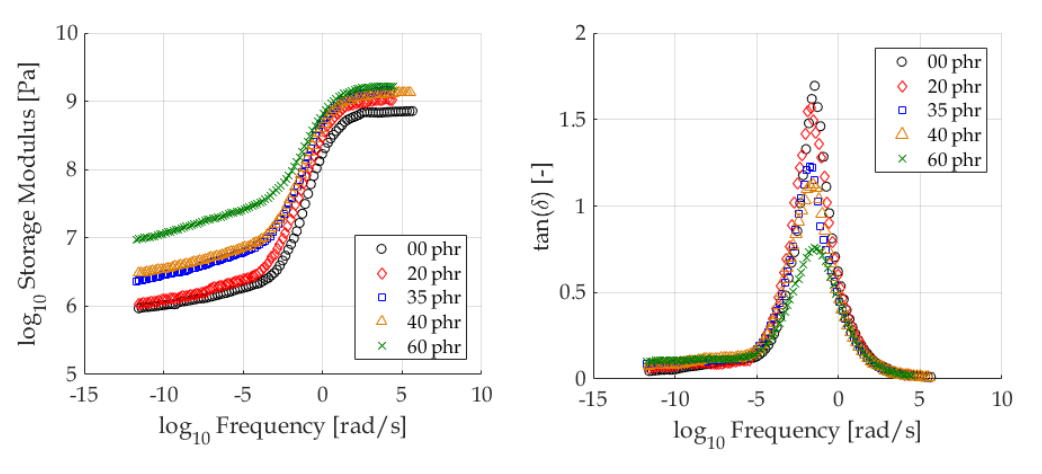
Figure 10. Raw data adapted from [20] for SBR material with different concentrations of CB.